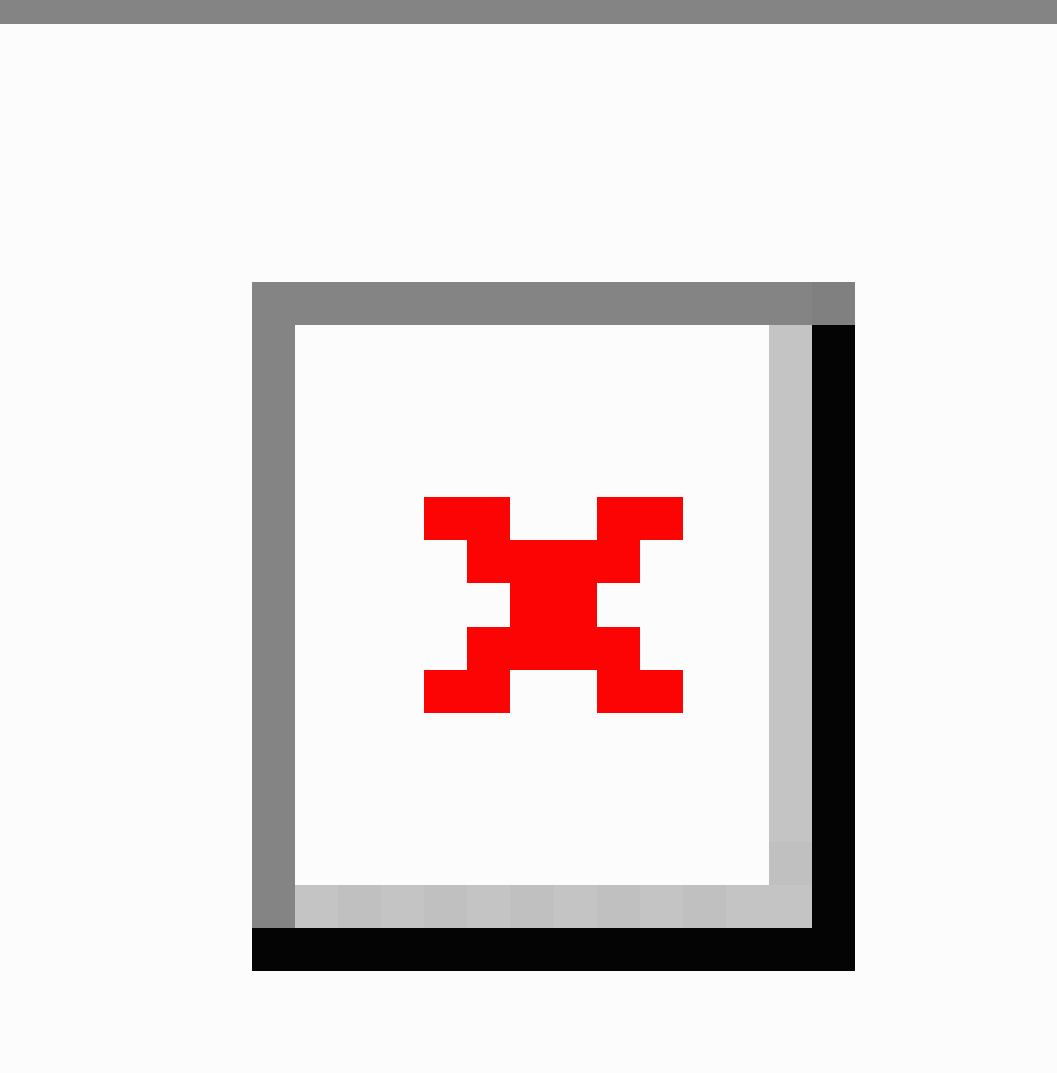
Figure 3. Overview of the Multiplex Blood Culture Test (MuxBCT) system design. The medical laboratory technician (MLT) will use the MuxBCT app for facilitation of the MuxBCT diagnostic test. The MLT can use a wireless barcode scanner to enter barcodes into the tablet app. Clinical microbiologists can access the MuxBCT results through the LIS. The HTTPS protocol is used to ensure encrypted communication of data. The arrowheads indicate direction of data flow. Dashed lines in the figure indicate wireless